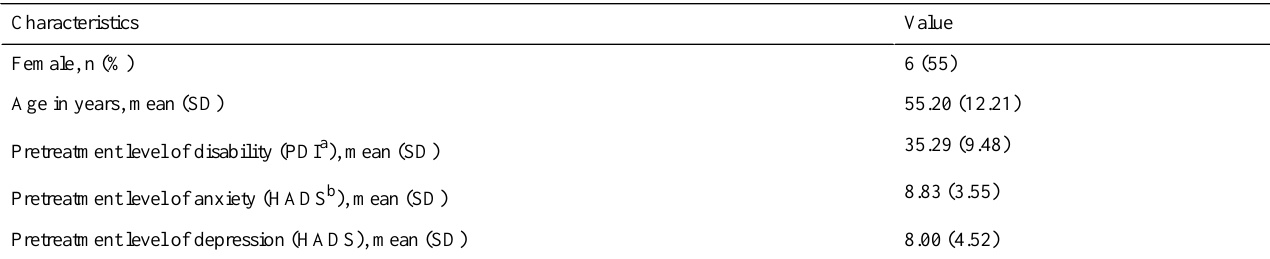
Table 1. Overview of patient participant characteristics (n=11).